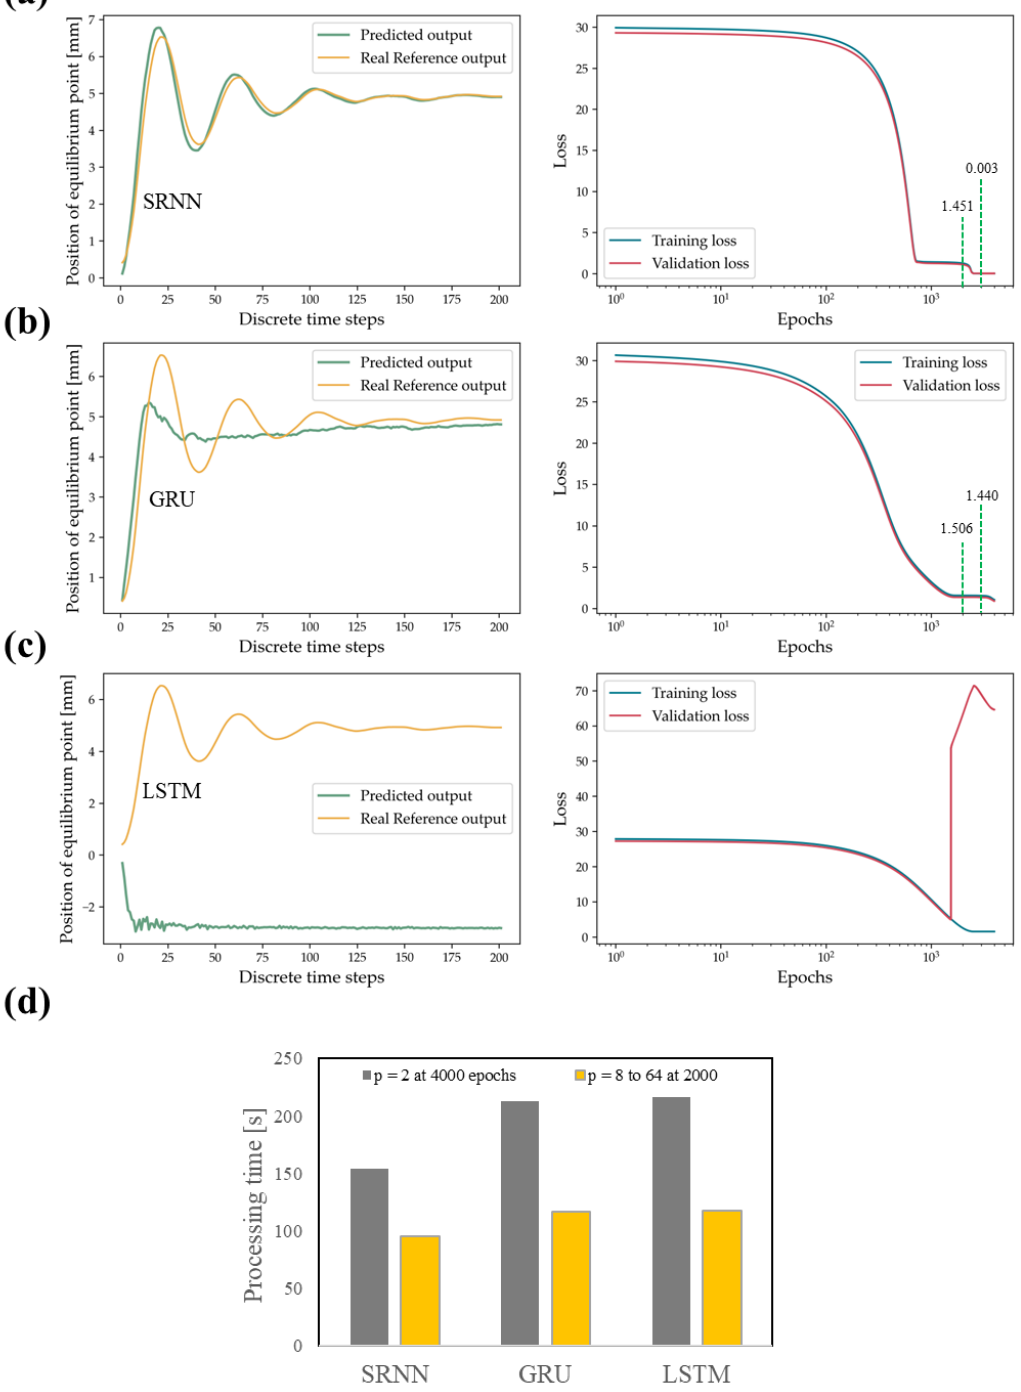
Figure 9. Prediction performance, training, and validation losses for modified neural networks; ( a ) SRNN, ( b ) GRU, ( c ) LSTM architectures and ( d ) Comparison of processing times using 2 units and 4000 epochs or 8 – 64 units and 2000 epochs.